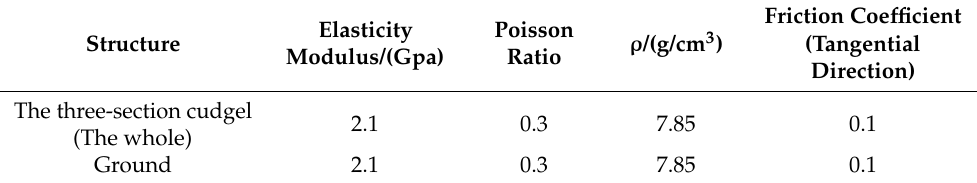
Table 1. Model material parameters.